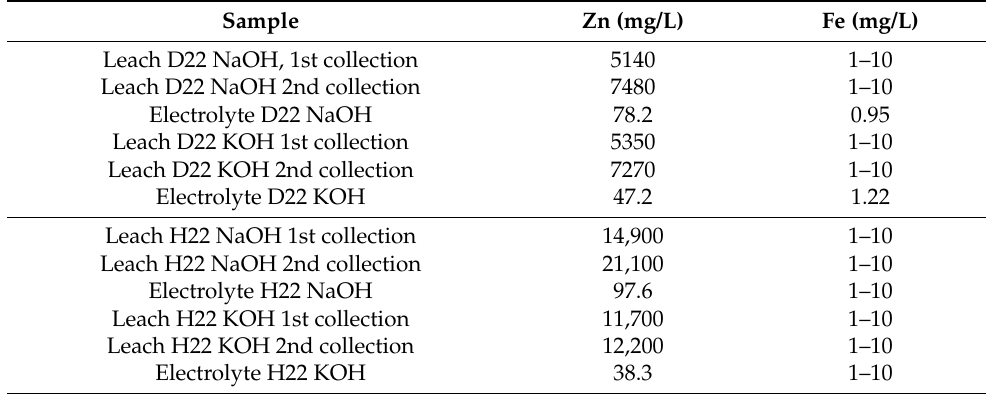
Table 18. The results of AAS analyses of the leaches (1st sampling after 4 h, 2nd sampling after 8 h of leaching) and of the electrolytes after finishing.